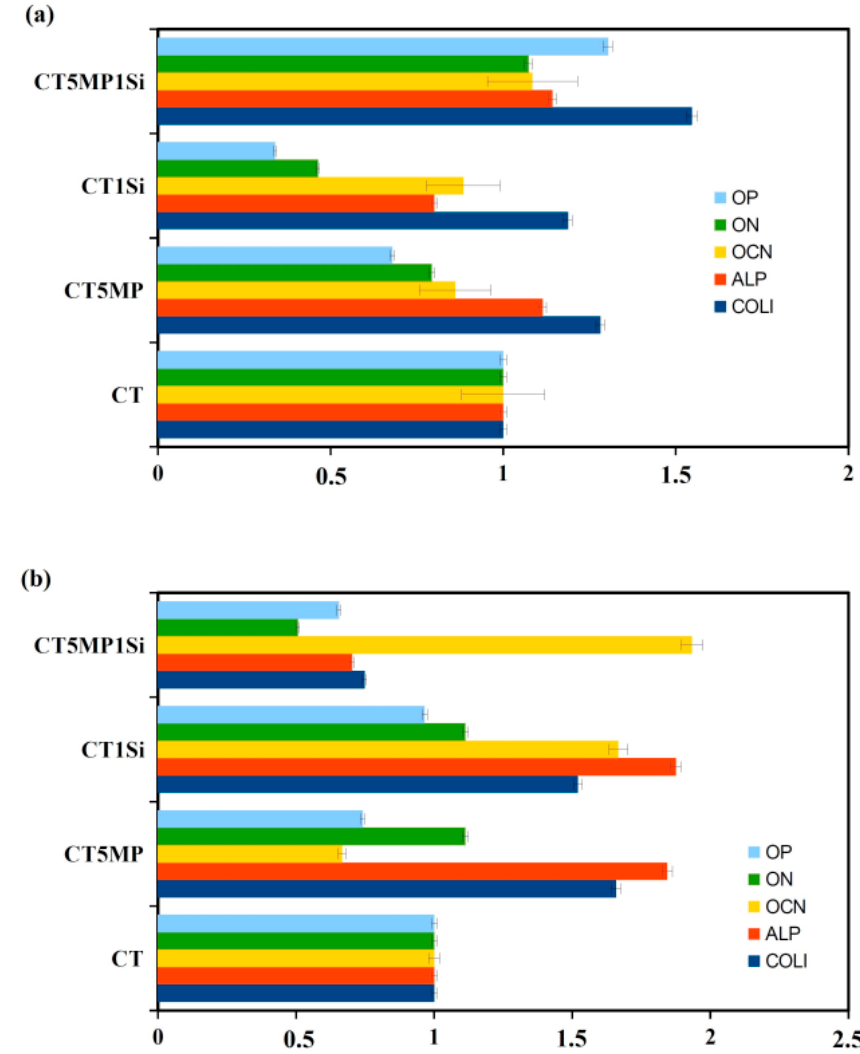
Figure 9. Relative gene expression of OP, ON, OCN, ALP, and COL1 in MSCs cultured for 7 ( a ) and 14 ( b ) days.